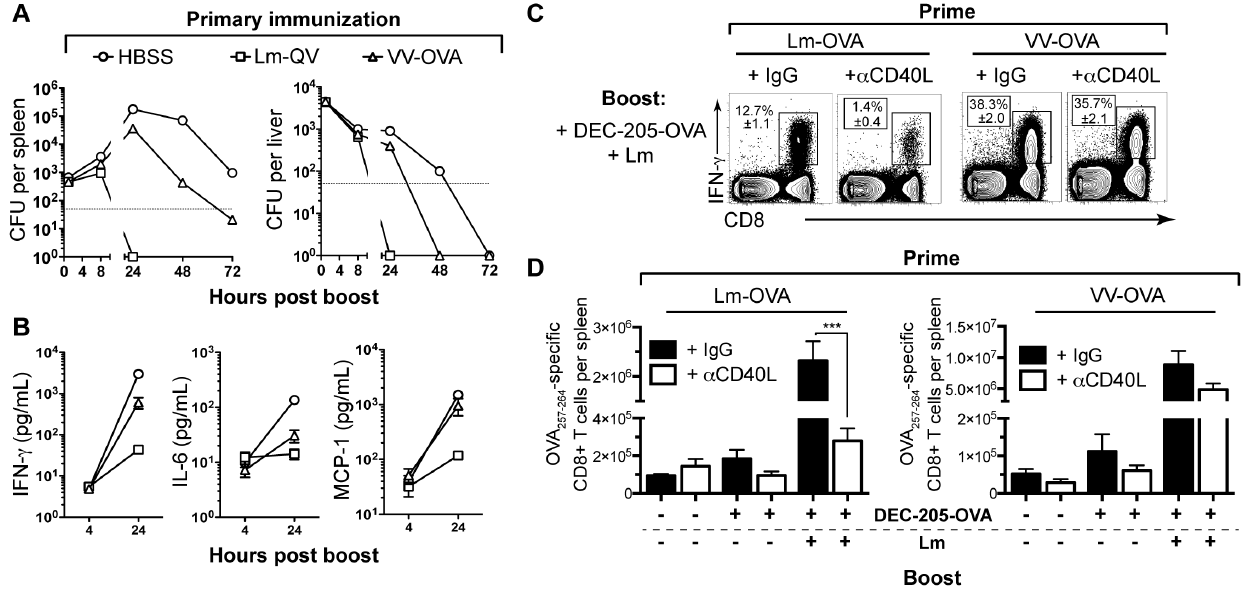
Figure 6. Accelerated clearance of homologous vaccine vector limits inflammation and correlates with increased CD40L dependence. (A–B) Mice were primed with 10 7 cfu Lm-OVA, 10 6 pfu VV-OVA, or HBSS and boosted 21 days later with 10 7 cfu Lm-QV ( n =5). (A) Spleens and livers were harvested at 24, 48, and 72 hours following boost, and cfu were enumerated by plating organ homogenates (mean, 6 SEM). (B) Serum cytokine levels at 4 and 24 h following boost (mean, 6 SEM). (C–E) Mice were primed with 10 7 cfu Lm-OVA or 10 6 pfu VV-OVA and boosted 21 days later with 5 m g DEC205-OVA alone, 5 m g DEC205-OVA with 10 5 cfu Lm-OVA, or HBSS. a CD40L or control antibody was administered to the indicated groups during boost. OVA 257–264 -specific memory CD8 + T cell responses were assessed 5 days post-boost using intracellular cytokine staining for IFN- c ( n =5). (C) Representative plots of OVA 257–264 -specific T cell enumeration (median shown, 6 SEM). (D) Total OVA 257–264 -specific (IFN- c + ) CD8 + T cells per animal (mean, 6 SEM). *, P , 0.05, **, P , 0.01, ***, P , 0.001, ANOVA. Data are representative of two independent